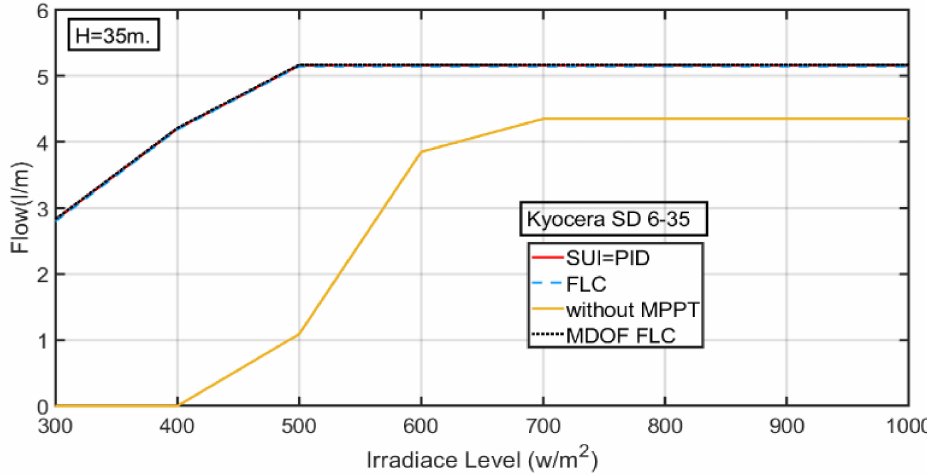
Figure 18. Performance analysis of the volume flow rate at a head of 35 m.